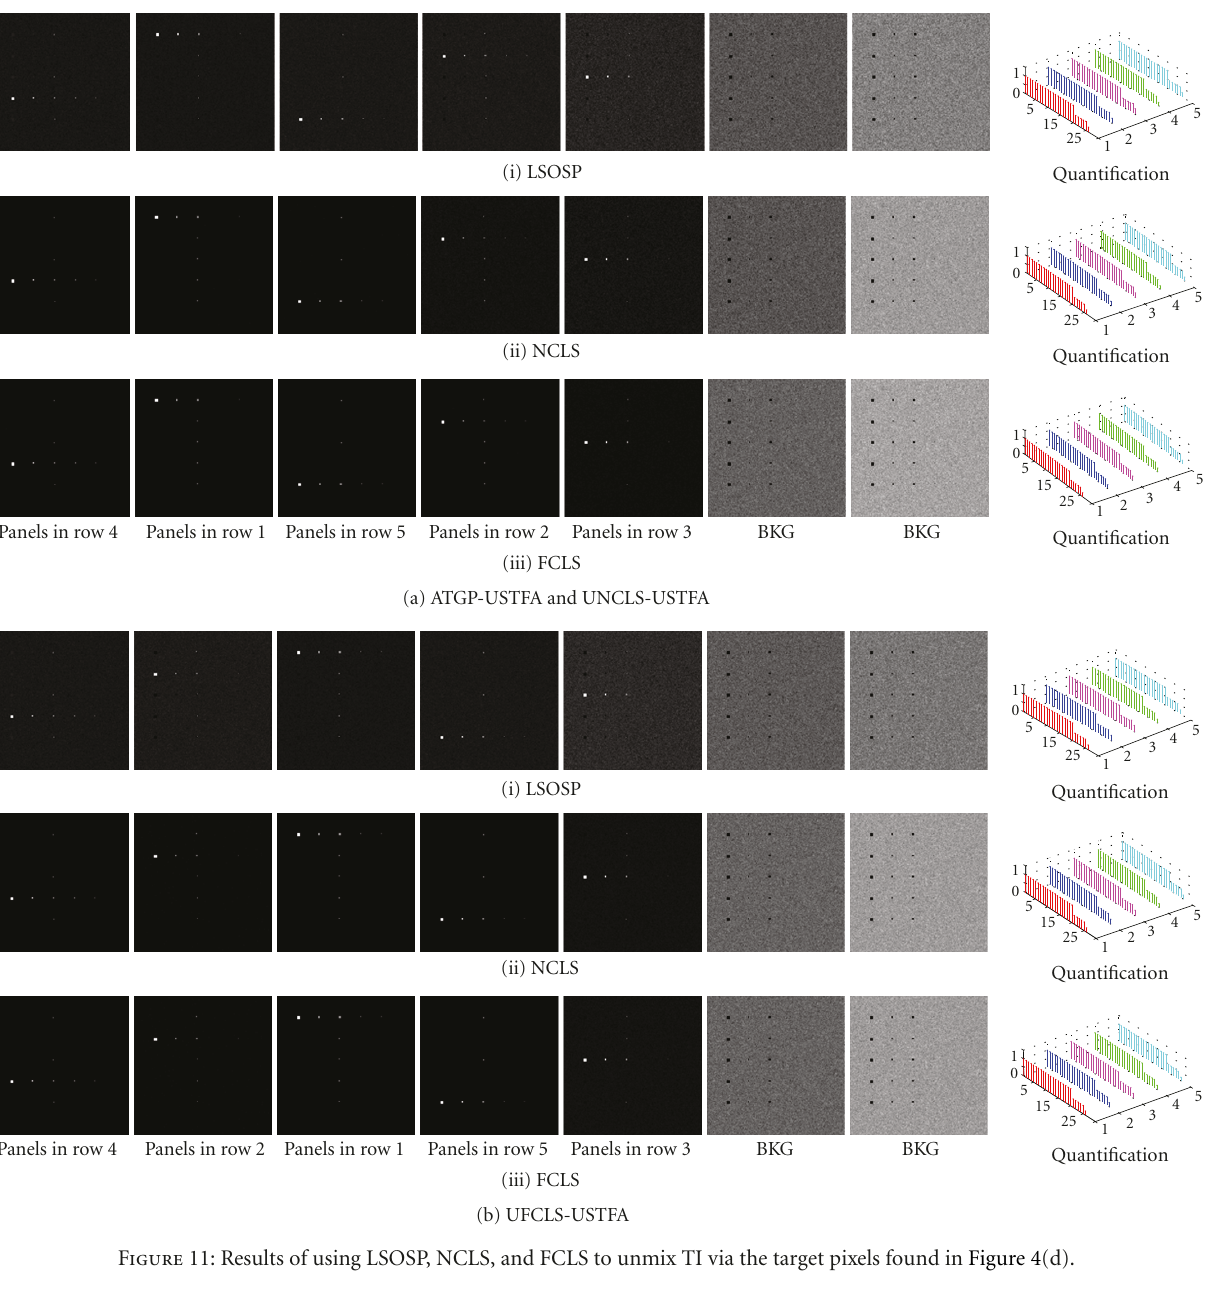
respectively. Since LSOSP is unconstrained, the 20 pure panel pixels in row 3 were overestimated in Figures 12(b)–12(i) by for using the subpanel pixel p 3 5,1